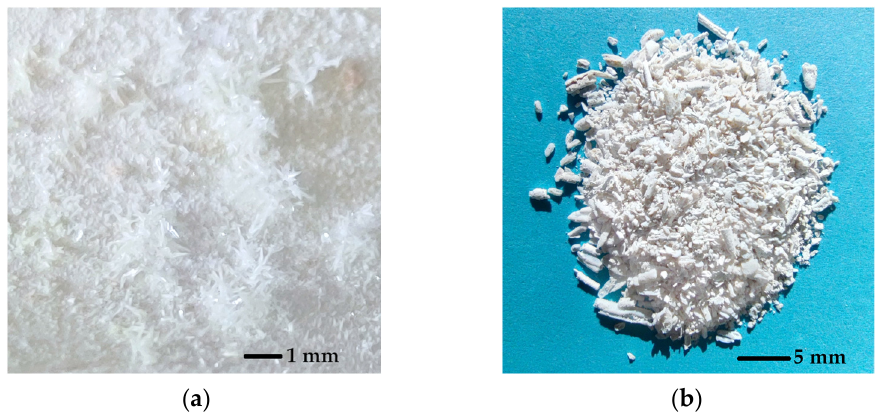
Figure 9. Condensate from the copper telluride roasting on the surface of the condenser ( a ) and in the free state ( b ).